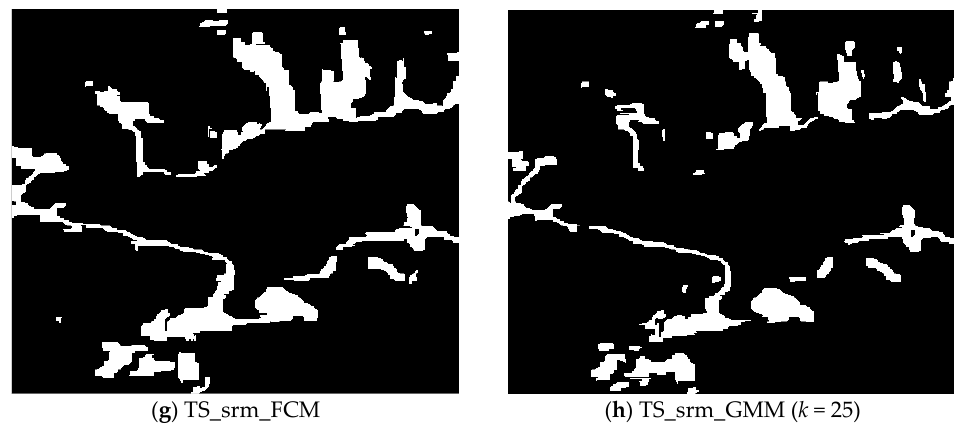
Figure 12. Change detection results of the different algorithms over LiangZi Lake.